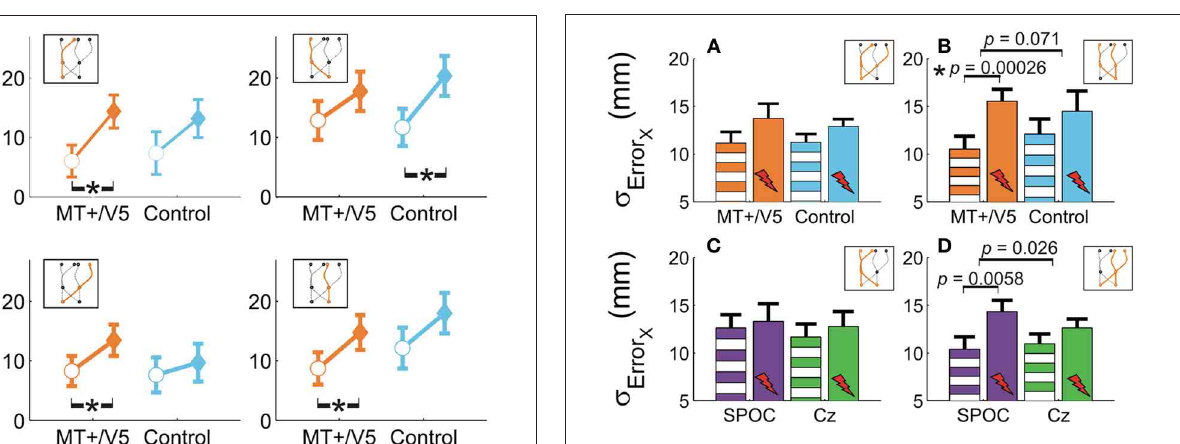
FIGURE 4 | Vertical interception errors for MT + /V5 and its posterior control site for all four trajectory types (trials with rTMS: solid diamonds; trials without rTMS: open circles). Error bars indicate standard errors; asterisks indicate significant differences.